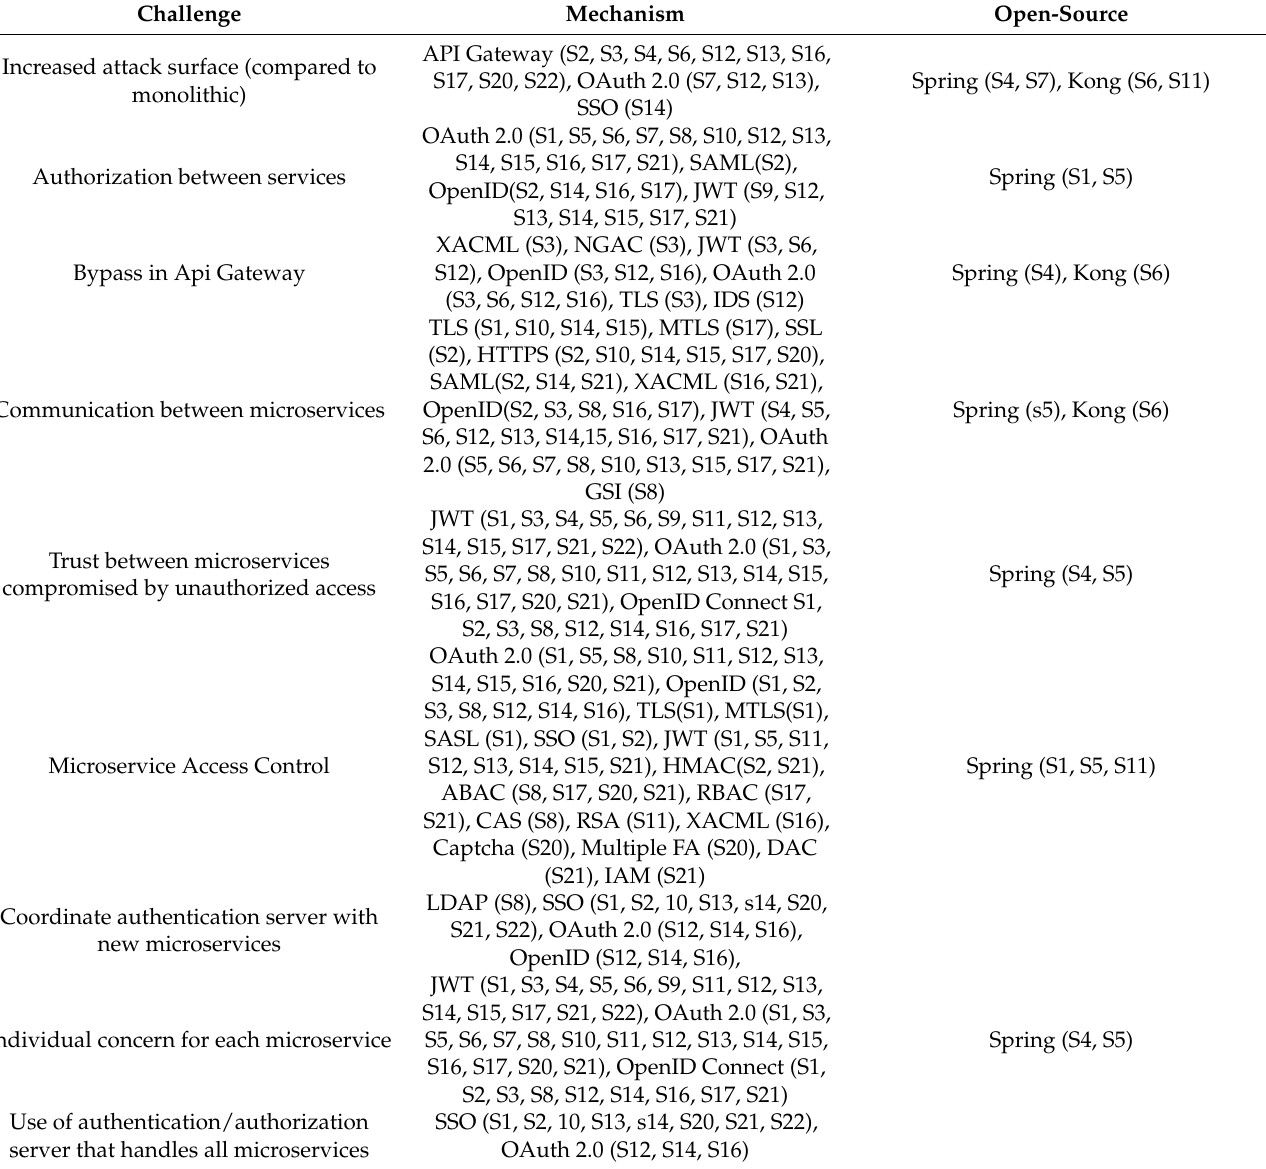
Table 7. Linking Challenges, Mechanism and Open-Source